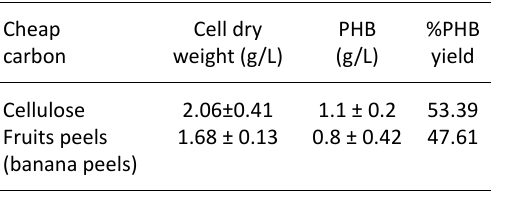
Table 10. Influence of cheap carbon sources on production of PHB by Bacillus